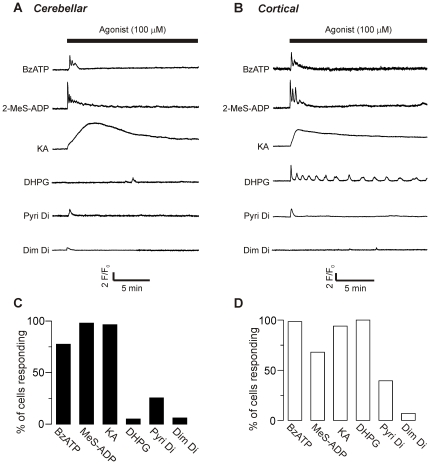
Pharmacological characterization of receptor types.Representative traces of changes in fluorescence intensity over time after addition of pharmacological agonists (at 100 µM) selective for P2X receptors (BzATP), P2Y receptors (2-MeS-ADP), AMPA/kainate receptors (KA), mGlu receptors (DHPG), H1 receptors (Pyri Di) and H2 receptors (Dim Di), in cerebellar (A) and cortical (B) cells. C) Percentage of cerebellar and D) cortical cells responding to each agonist. Data for each agonist are from 3–6 coverslips of cells, obtained from 2–3 culture preparations. Total cells tested for each agonist ranged from 64 to 202.